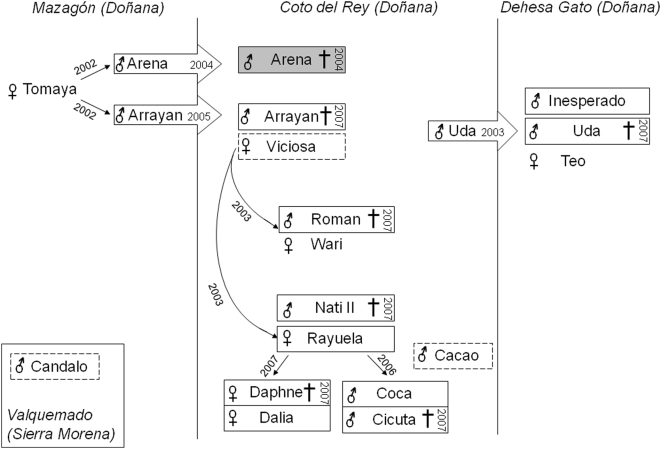
Overview of the geographical distribution and relationships between FeLV-infected lynxes.The regions of Mazagón, Coto del Rey and Dehesa Gato (Doñana National Park), and of Valquemado (Sierra Morena) are depicted schematically. All animals are identified by names. Large open arrows indicate migration after birth, accompanied by the year of migration. Symbols indicate females and males. Dead animals are indicated by a cross (†) accompanied by the year of death. Small arrows indicate descendants of the females, and the birth year is also indicated. Frames with dashed lines indicate FeLV-infected animals; frames with continuous lines indicate FeLV-infected animals from which the FeLV env genes were sequenced. Gray shading (animal “Arena”) indicates the FeLV variant most distantly related to the other FeLV found in these lynxes. The names of lynxes having close contact are positioned in close vicinity.